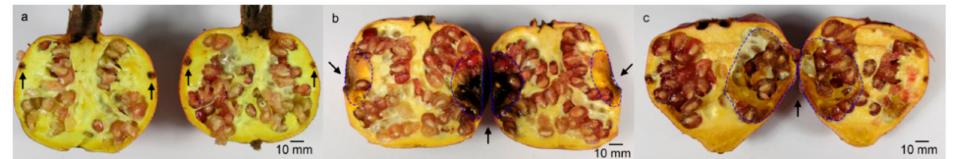
Figure 2. Control pomegranates ( a ), and pomegranates infected by pathogen A ( b ) and infected by pathogen B ( c ) after 6 days in the chamber (28 ◦ C, 90% RH).